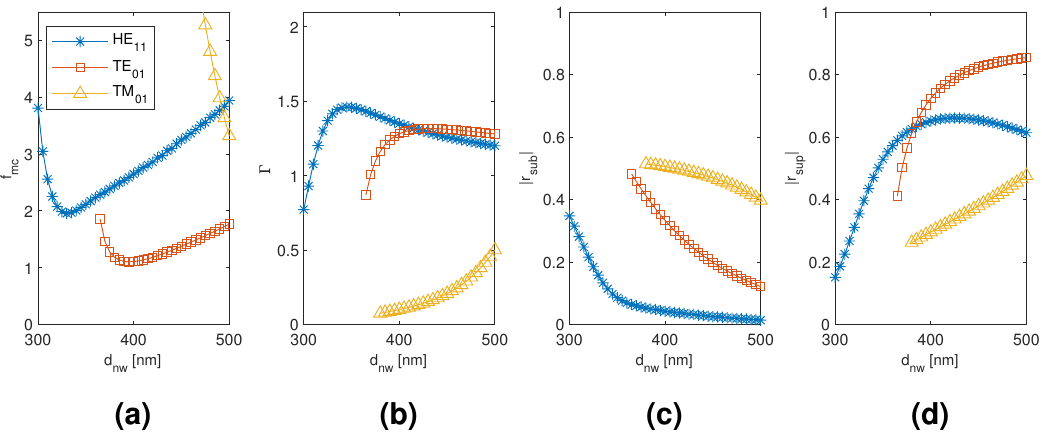
Figure 4. The results for the nanowire monomer HE 11 , TE 01 , and TM 01 mode as a function of the nanowire diameter. ( a ) modal cost function value; ( b ) modal confinement factor; ( c ) substrate modal reflection coefficient magnitude; ( d ) superstrate modal reflection coefficient